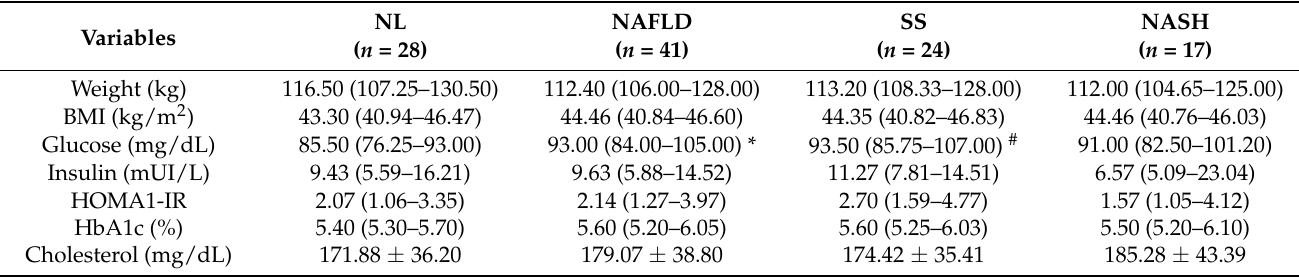
Table 1. Anthropometric and biochemical variables of the cohort with MO, classified according to the hepatic histopatho- logical